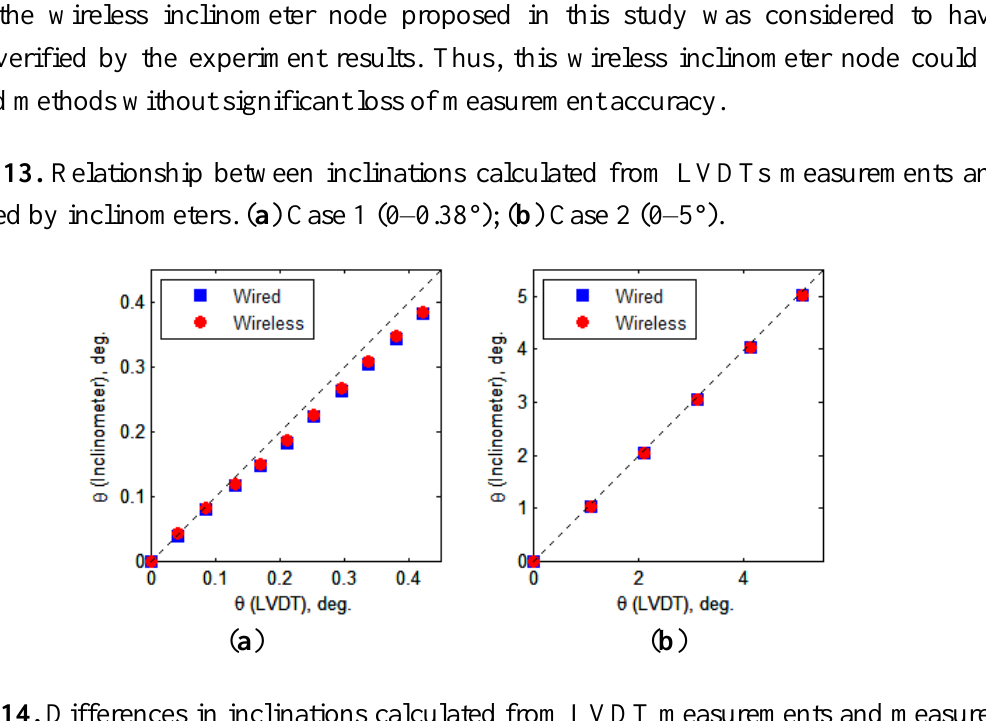
Figure 14. Differences in inclinations calculated from LVDT measurements and measured by inclinometers. ( a ) Case 1 (0–0.38°); ( b ) Case 2 (0–5°).